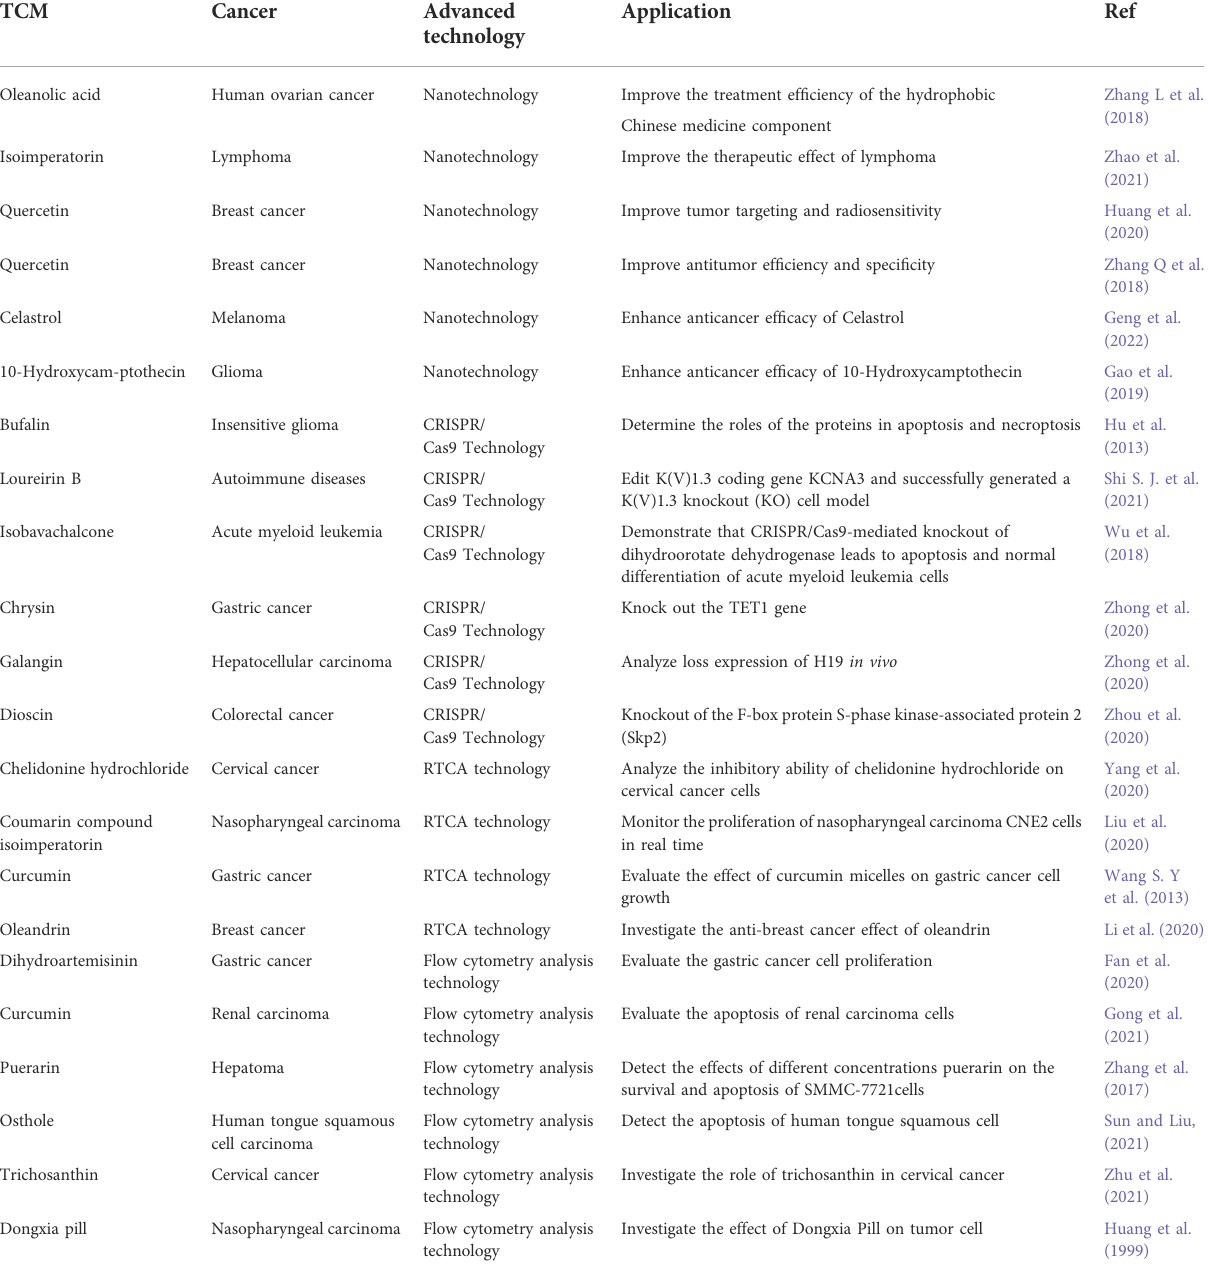
TABLE 1 The application of advanced technology in tumor treatment